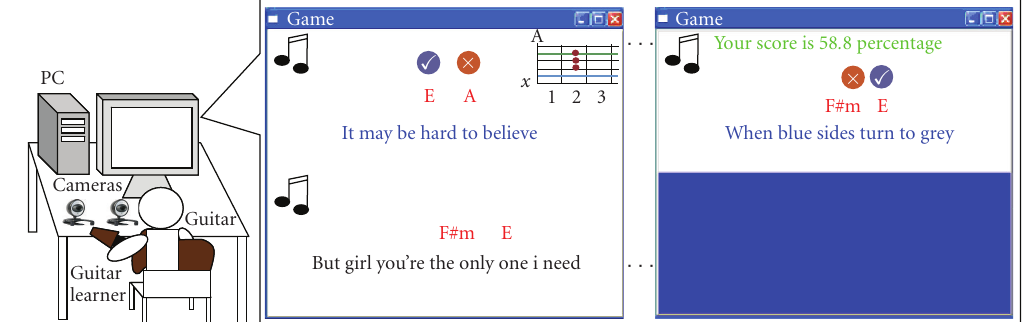
Figure 6: User interface of our guitar application.